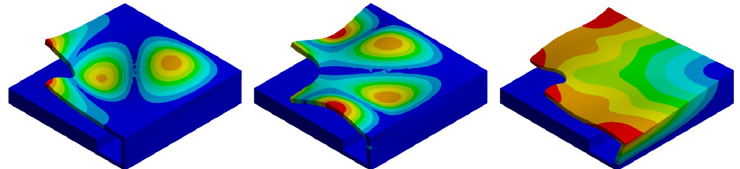
Figure 21. Three package modes for case (d): 6th mode shape at 91.53 kHz ( left ), 7th mode shape at 101.82 kHz ( center ), 8th mode shape at 108.23 kHz ( right